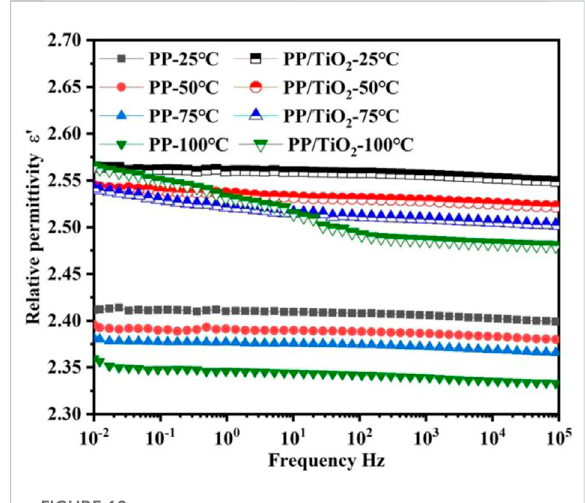
FIGURE 10 Relative permittivity spectrum at different